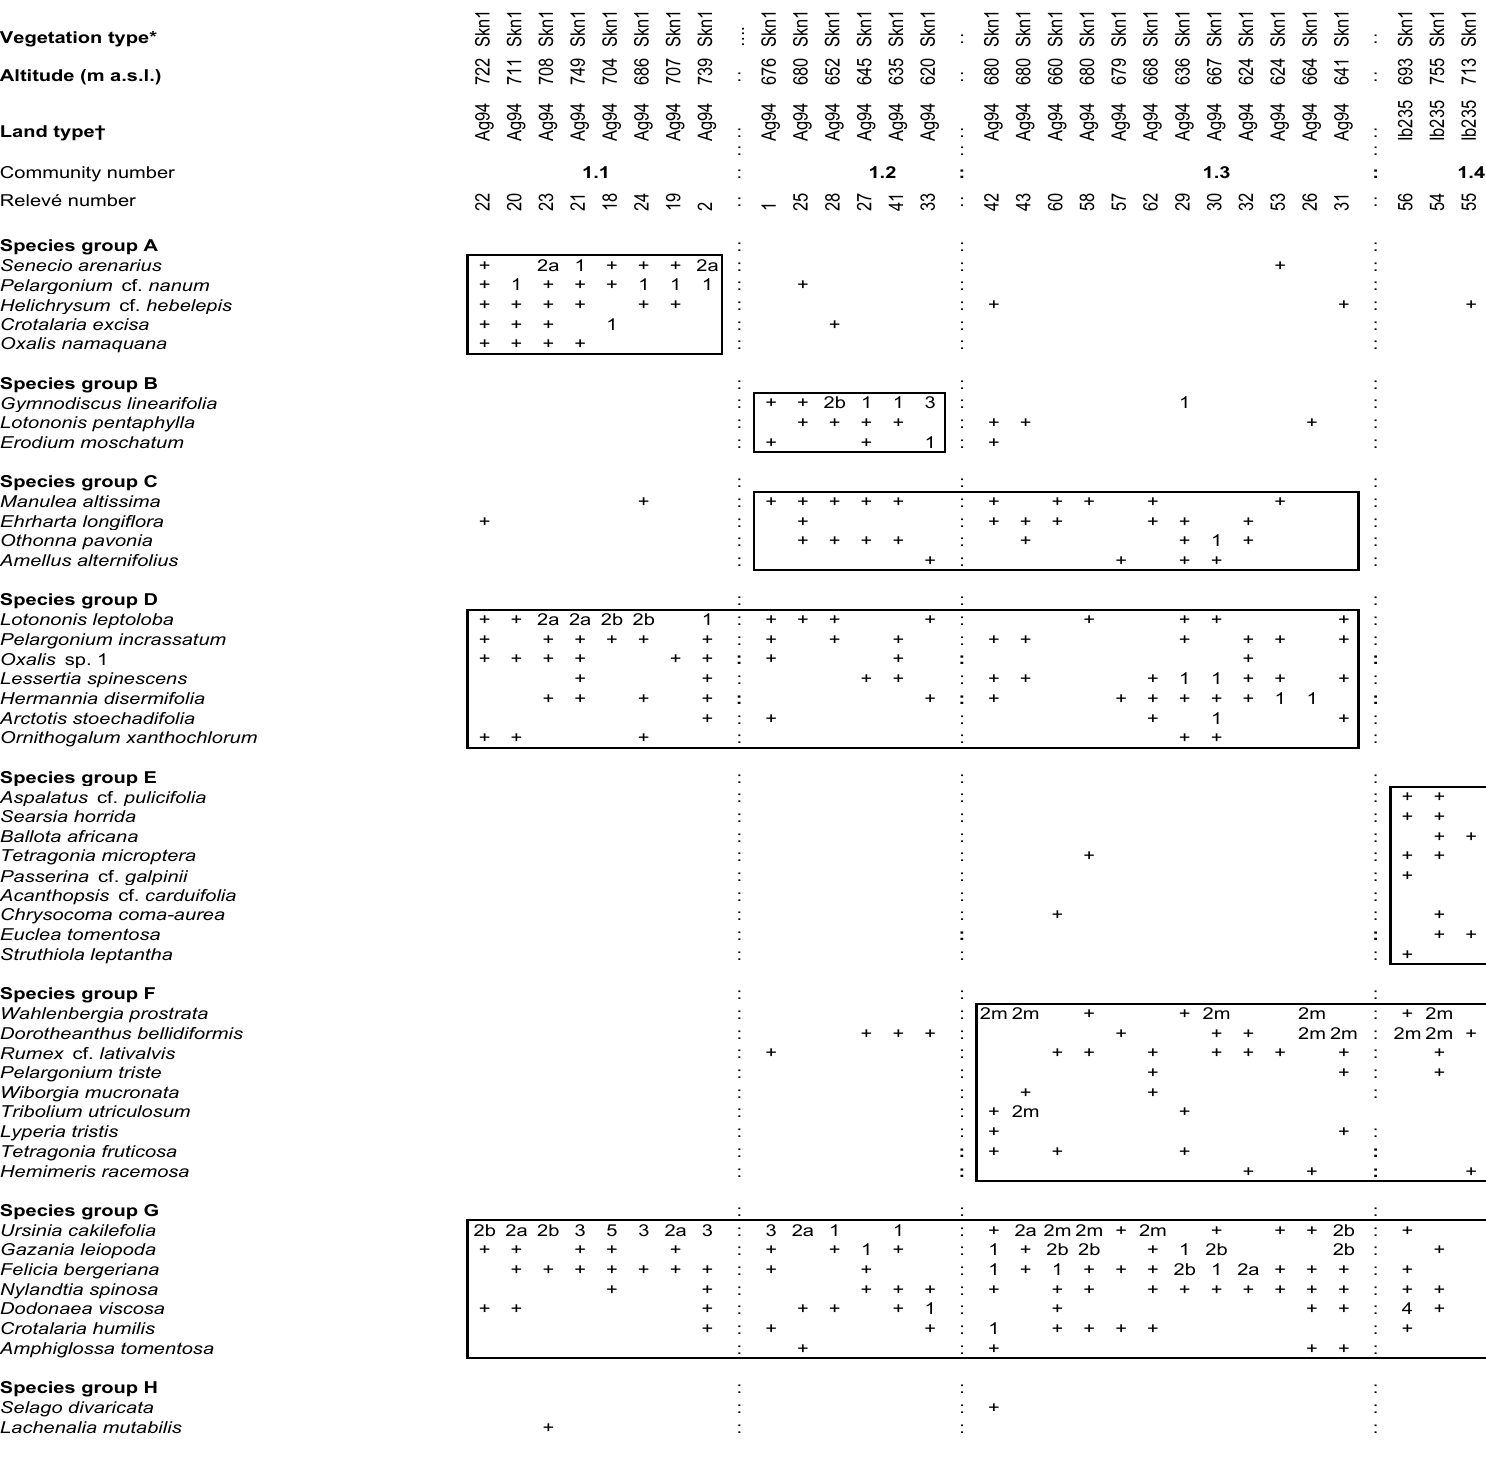
Species group B